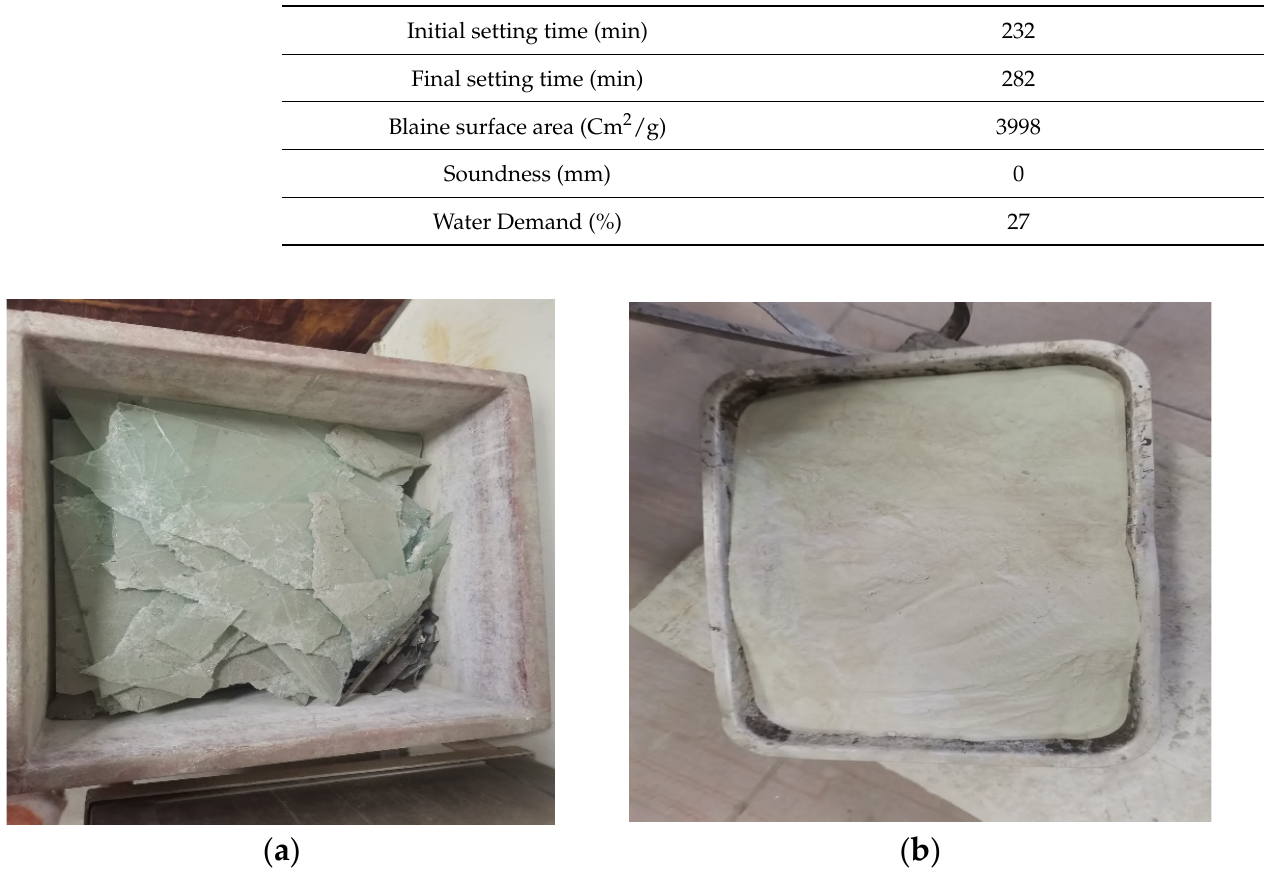
Figure 1. Waste glass: ( a ) pieces of glass; ( b ) fi ne aggregate/particles of glass (75 µm).